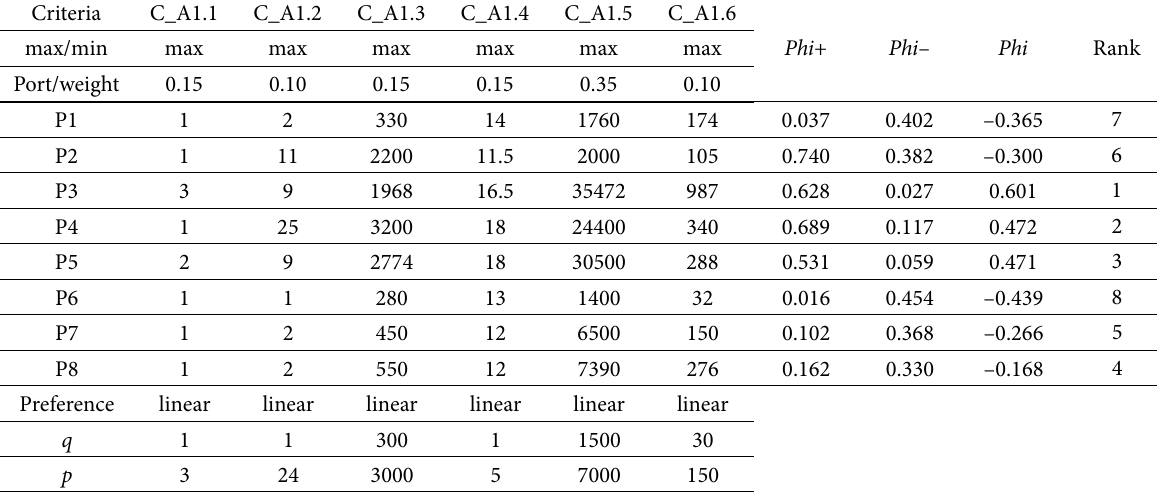
Table 3. PROMETHE II complete rank of the ports for A1 sub-criteria set